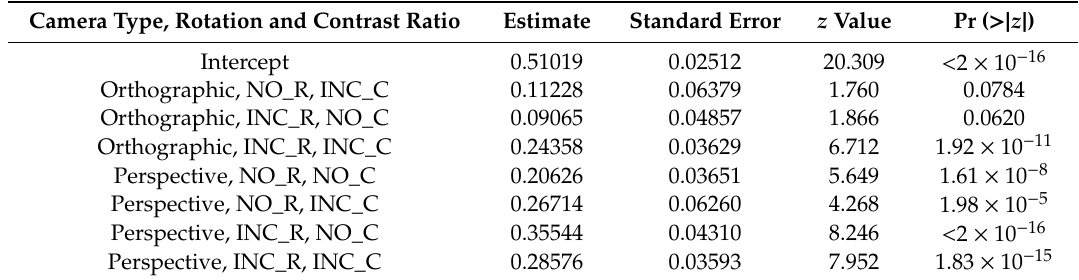
Table 28. Logistic regression analysis results investigating the e ff ects of the camera type, rotation, and contrast ratio.